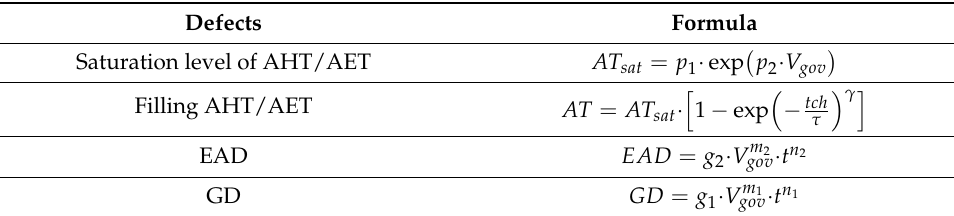
Figure 17. ( a ) The progressive charging–discharging technique for extracting the saturation level of AHTs; ( b ) the orange curve is the saturation level of AHTs at a given |Vg − Vth| [37,53]. Table 1. The formula of the as-grown-generation (AG) model for BTI.